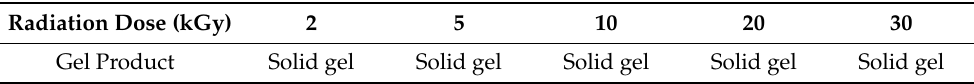
Table 3. Radiation dose and respective gel products for APTAC + AAc + DADMAC. Radiation Dose